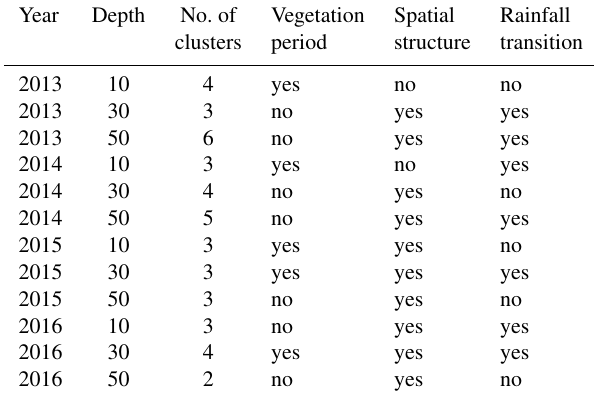
Table 1. Qualitative description of method success in all years and depths. The results from years other than 2016 and all depths were inspected visually and are summarized here for the sake of com- pleteness. The first three columns identify the year, sensor depth and number of clusters found by mean shift. The remaining three columns state whether specific features existed in the given result. Vegetation period marks whether or not the vegetation period was characterized by a single, or two, clusters. Spatial structure : does a dependency of dispersion on distance exist outside the vegetation period? Rainfall transition : were cluster transitions accompanied by a rainfall event in close (temporal) proximity? This feature is marked “yes” if it was more often the case than it was